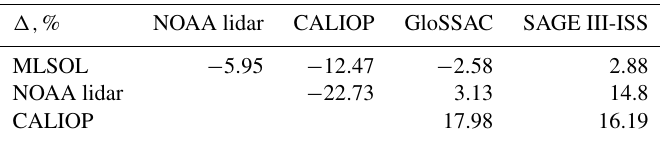
(cid:16) X (cid:17) × 100% to ease comparison with Khaykin et al. (2017) row + X column 2